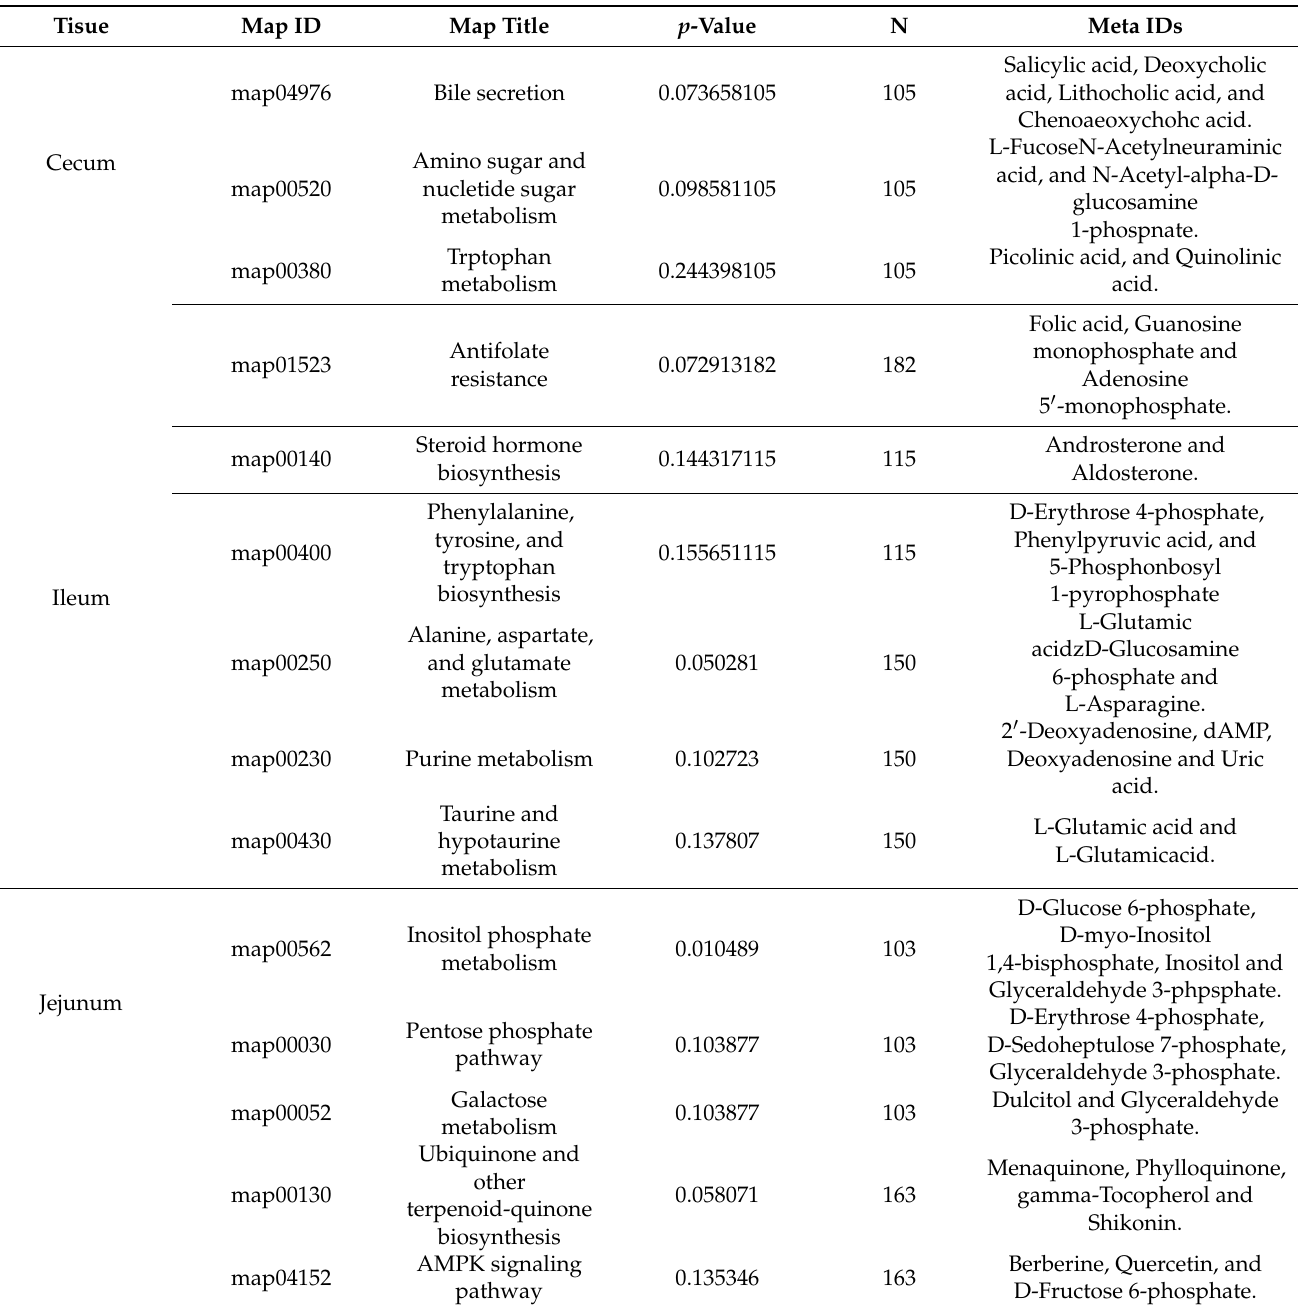
Table 2. Diarrhea group (Dia) and normal group (Con) Hyplus rabbits’ cecum, ileum, and jejunum tissue samples for KEGG enrichment